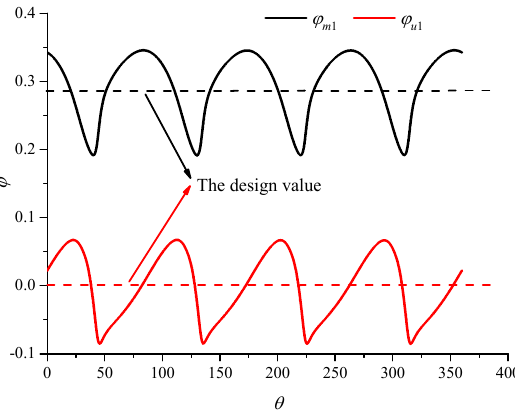
Figure 15. The velocity coefficient distribution along the circumference at A3.